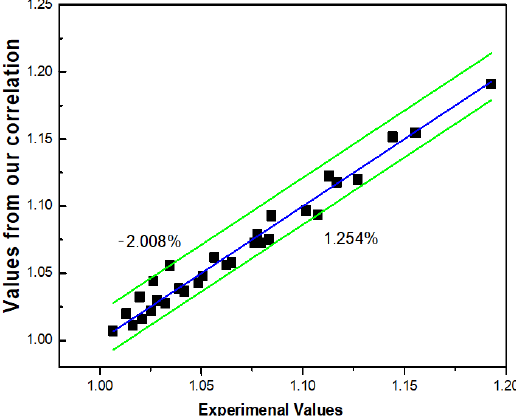
Figure 9. Deviation between the output value of the correlation and the experimentally measured value.